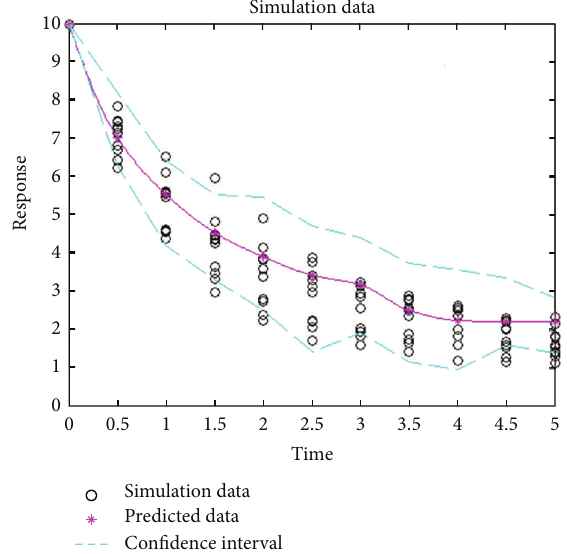
Figure 1: Simulation data are given by the circle and prediction data aregiven by theasterisklinked ina line. The95% credibility intervals are given by the dotted